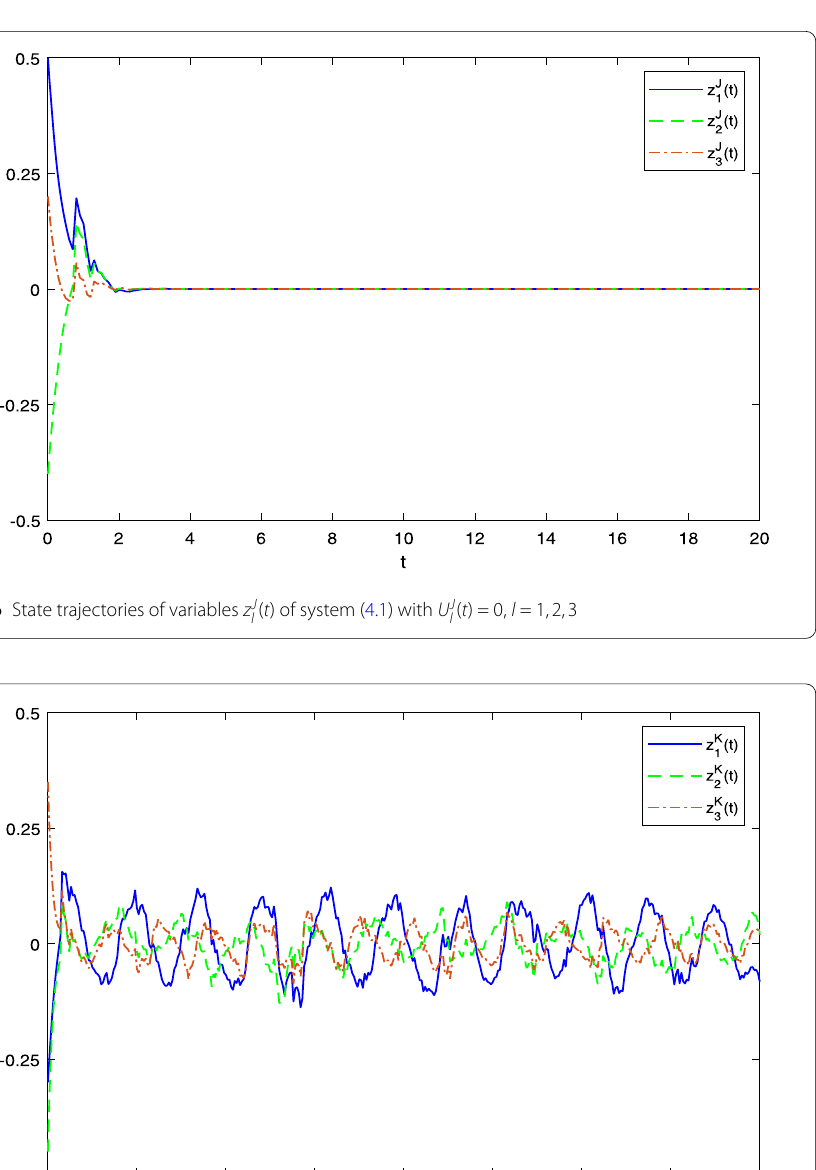
( t ) of system (4.1) with U K l